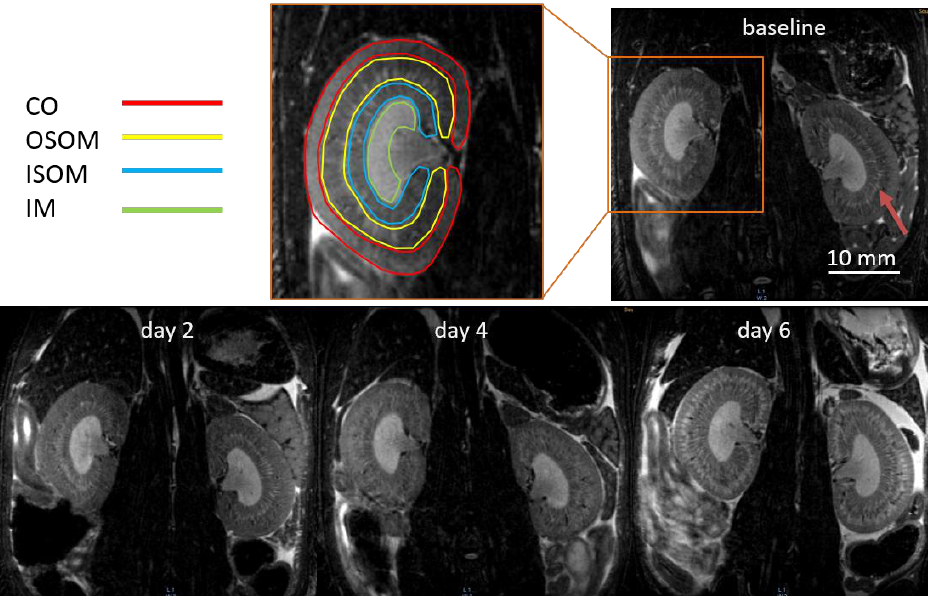
Figure 2. Examples of isotropic T2-weighted images of AAI-treated kidneys. At baseline, four kidney layers are outlined with contours of different colors in the zoomed image. CO, cortex; OSOM, outer stripe of outer medulla; ISOM, inner stripe of outer medulla; IM, inner medulla. Representative T 2 maps of the AAN (upper row) and the control group (lower row) are illustrated in Figure 3. For kidneys without AAI, T 2 showed an increased gradient from CO to IM. For the AAN group, T 2 of CO and OSOM were increased to day 6. The outcome of the statistical analysis of T 2 of the AAN group is shown in Figure 4A. The T 2 increase of OSOM was immediately detected at day 2 (baseline vs. day 2 p = 0.005), while that of CO was not detected until day 4 (baseline vs. day 4 p < 0.006). T 2 of both layers were increased remarkably at day 6 (CO: baseline vs. day 6 p < 0.001; OSOM: baseline vs. day 6 p < 0.001). OSOM present the most pronounced T 2 change: T 2,day2 = 53.2 ms to T 2,day6 = 69.4 ms. T 2 of ISOM and IM increased until day 4 followed by a sudden decline observed at day 6, showing T 2 relaxation times being smaller than at baseline.